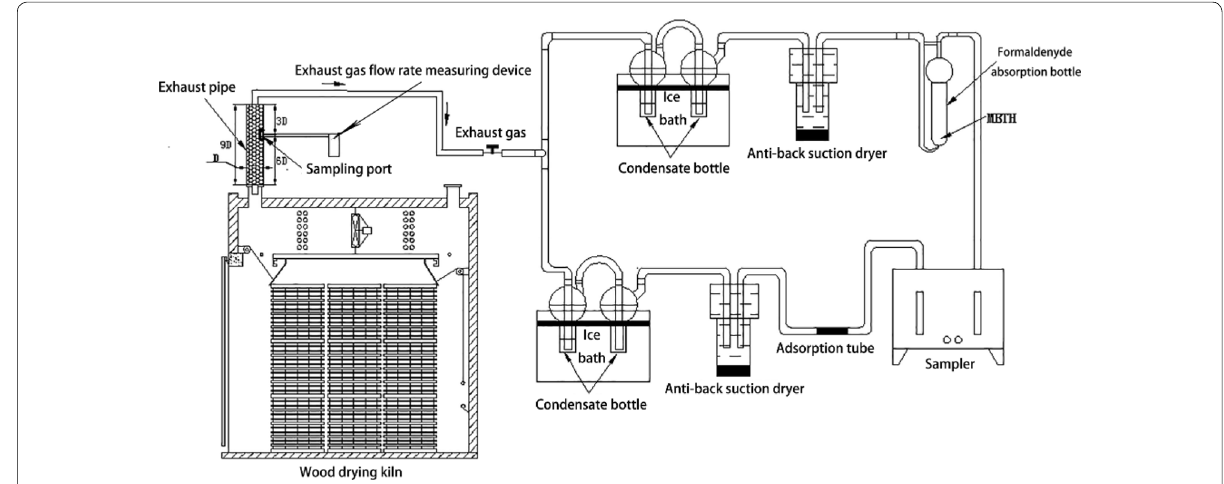
Fig. 1 VOCs collection device during